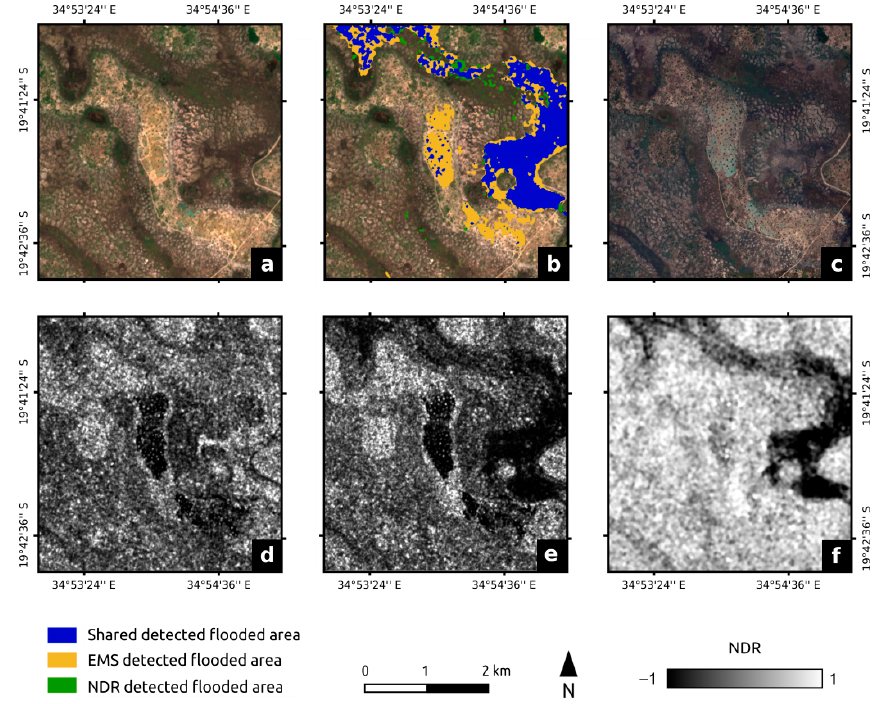
Figure 10. EMS Copernicus Beira basin false detection. ( a , b ) Sentinel-2 image from 2 December 2018; ( c ) Maxar 27 February 2019 (Google Earth); ( d ) Sentinel-1 from 18 February 2019; ( e ) Sentinel-1 from 20 March 2019; ( f ) NDR.